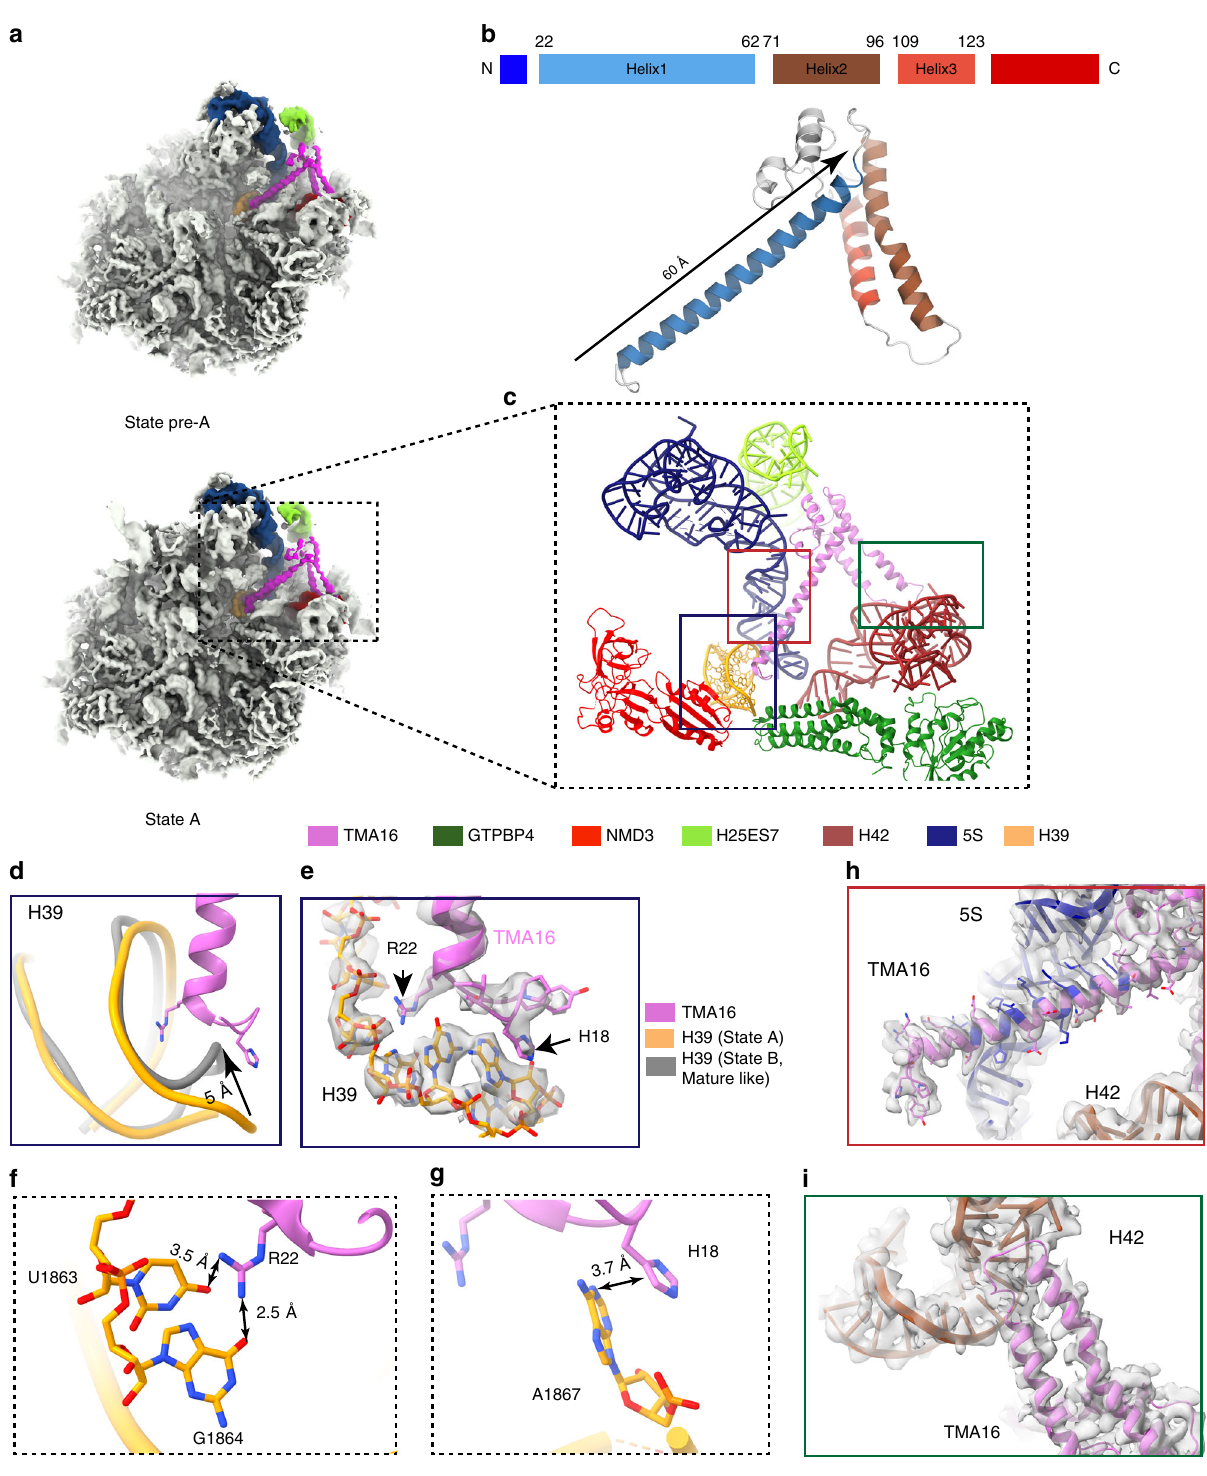
Fig. 2 Structure of human TMA16. a Cryo-EM maps of states pre-A and state A (Gaussian fi ltered with sDev of 1.058 Å), with TMA16, 5S rRNA, part of H25ES7, H39 and H42 color-coded. b Secondary structural elements and the atomic model of human TMA16. c Zoom-in view showing the surrounding of TMA16. Two PTC-located assembly factors are also shown (NMD3 and GTPBP4). The three boxed regions are further detailed in panels d , g and h . d Comparison of H39 in state A (orange) and state B (gray). e Interactions between the N-terminus of TMA16 and H39 (immature conformation) in state A. f R22 of TMA16 interacts with G1864 of H39. g , H18 of TMA16 stacks with the base of A1867 of H39. h , Interactions between the helix 1 of TMA16 and the 5S rRNA in state A. i , Interactions between the H2-H3 loop region of TMA16 and H42 of the 28S